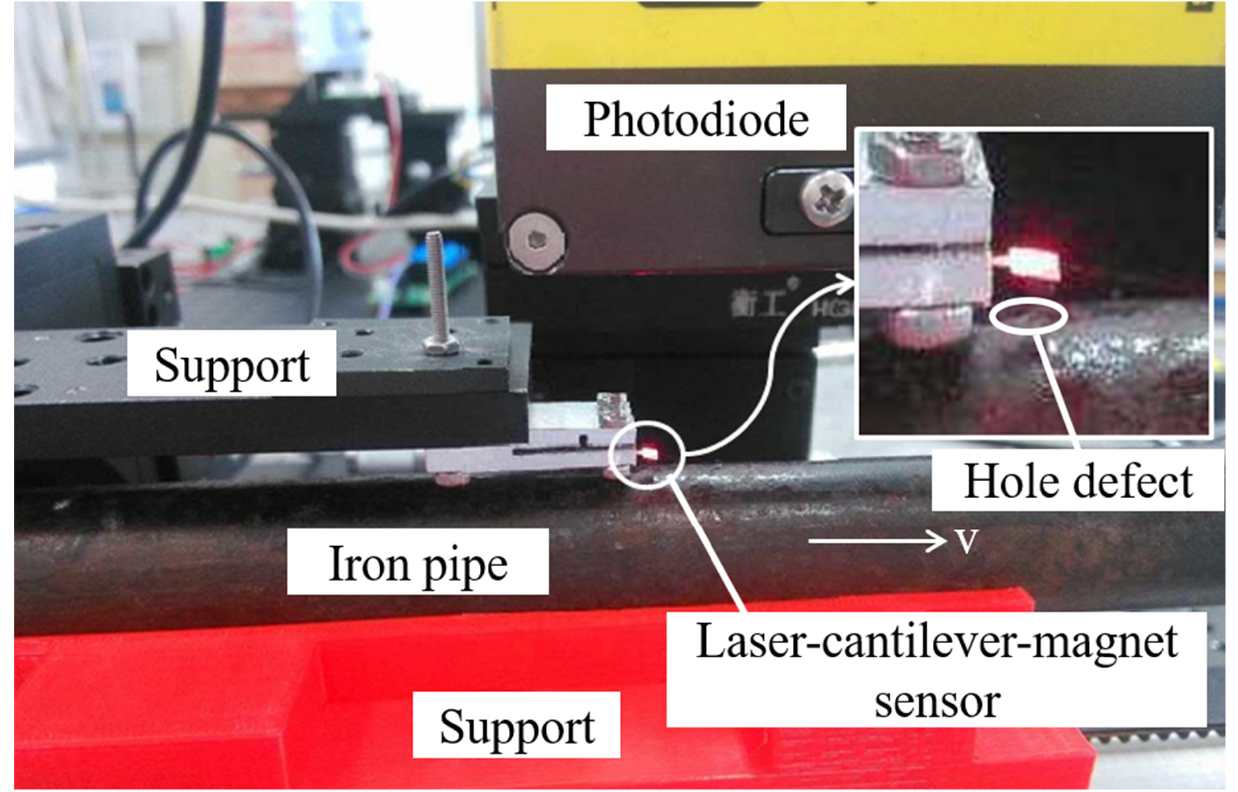
Figure 3. Magnetostatic force sensor with the laser, cantilever beam and small permanent magnet. The inset shows the laser–cantilever–permanent magnet